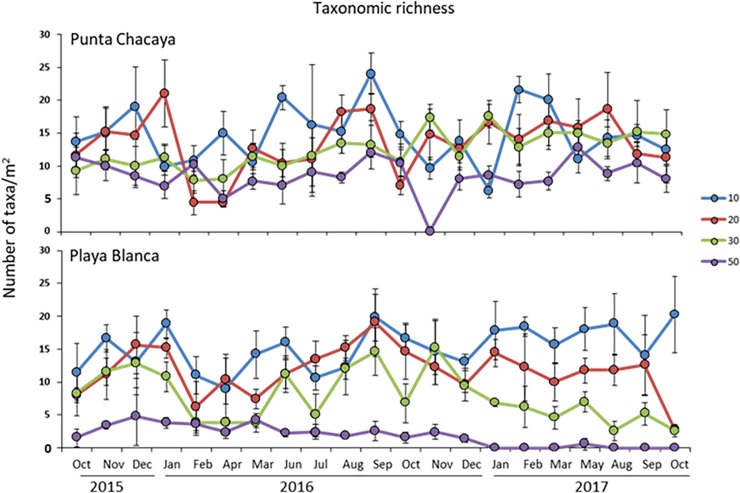
Variability in taxonomic richness.Temporal fluctuations in taxonomic richness (mean ± SD) of the macrobenthos per sampling site during the study period in Mejillones Bay. Color lines represent depth in m.